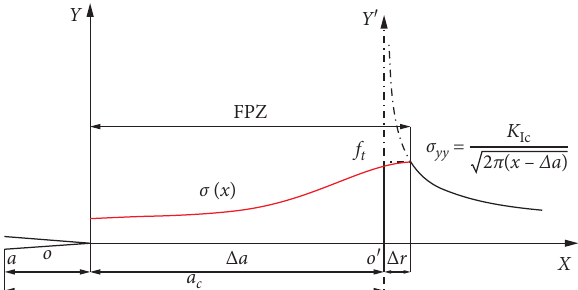
Figure 5: Stress distributions for fictitious crack model (Hillerborg et al.) and equivalent elastic stress